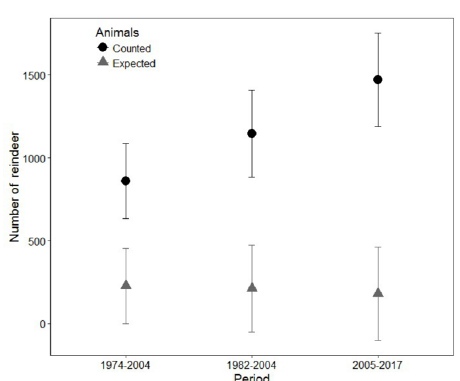
Figure 4. Mean annual number ± SE of wild reindeer counted vs. expected during air surveys south of the 66 kV power line before (1974-2004, 1982-2004) and after the upgrade to 132 kV (2005-2017). The year 1982 was the first year reindeer were known to graze on the